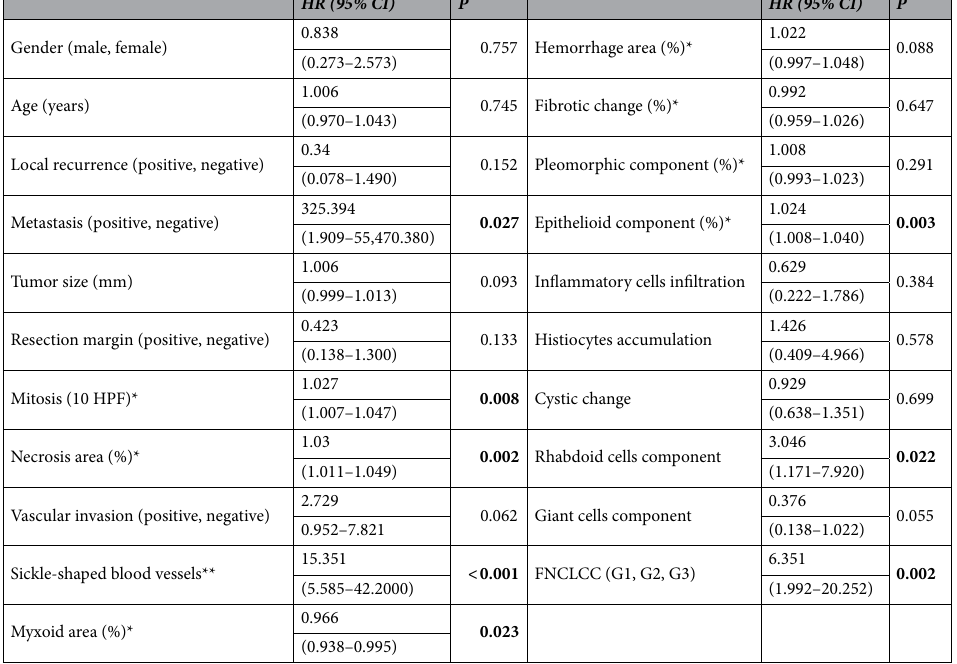
Table 3. Associations between clinicopathological findings and overall survival. Statistically significant P -values are shown in bold. *The HRs are for 1 mitosis or 1% increase. **For analysis of sickle-shaped blood vessels, we dichotomized the cases based on the number of vessels in the maximum cut-surface of each tumor into those with 1–99 vessels and those with ≥ 100 vessels.